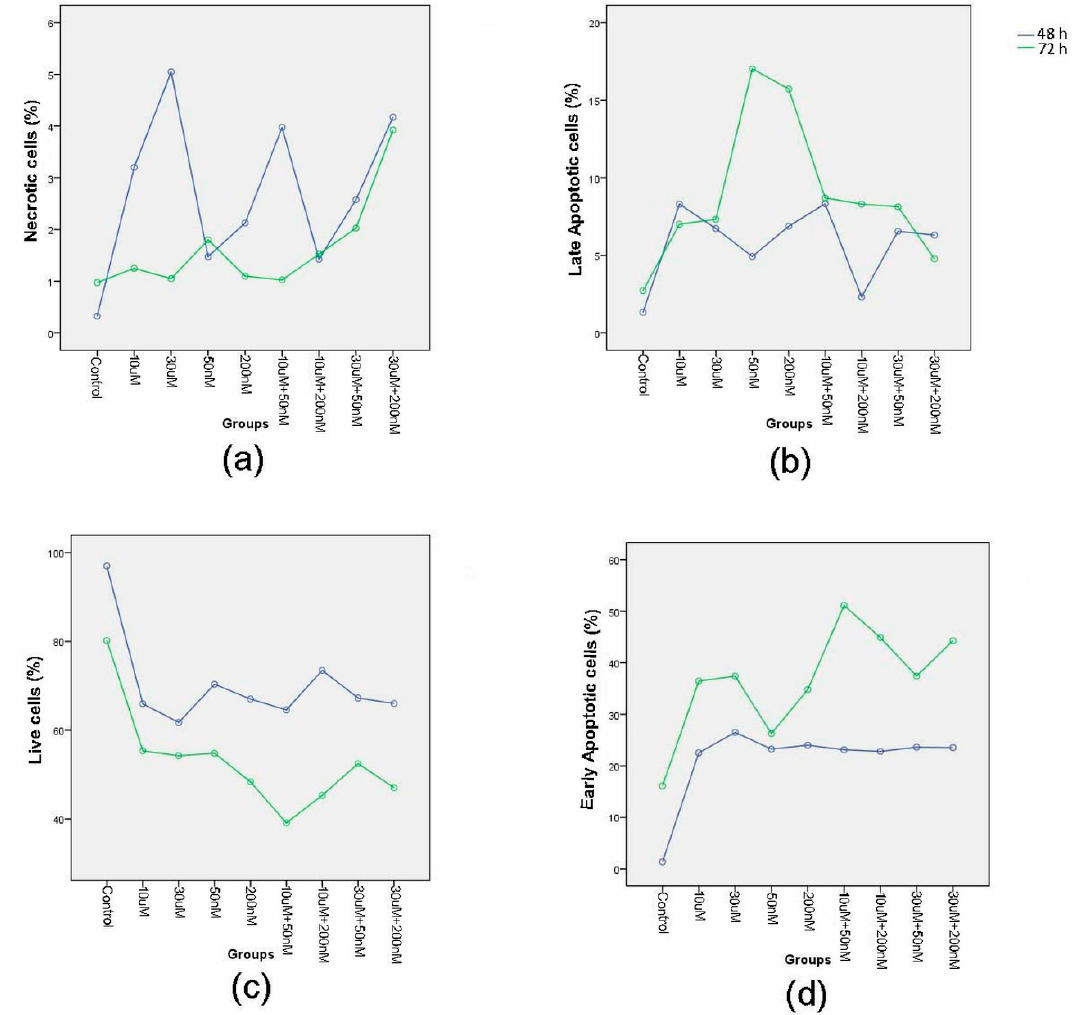
Figure 2. Perifosine and vitamin D induced apoptosis in a dose- and time-dependent manner. HEC- 1A cells were treated with perifosine (10 μ M 30 μ M), vitamin D (50 nM, 200 nM), and combinations of both (10 μ M + 50 nM, 10 μ M + 200 nM, 30 μ M + 50 nM and 30 μ M + 200 nM) induced apoptosis